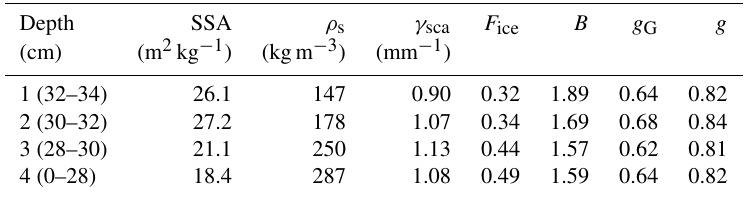
Figure 10. Polar plots of DCRF at 1000nm for incident zenith angles ranging from 5–85 ◦ . The reflected azimuthal direction is on the theta axis, and the reflected zenith angle is on the r axis. Color scale ranges from 0–1.5. Table 2. Physical and simulated optical properties of the top 8cm of snow measured at the UVD site on 12 February 2021. SSA and ρ s are computed directly from the µCT sample. Note that the depths correspond to the RTM depths for the virgin snow calculation. The geometric ( g G ) and total asymmetry parameters ( g ) are computed as described in Fig.